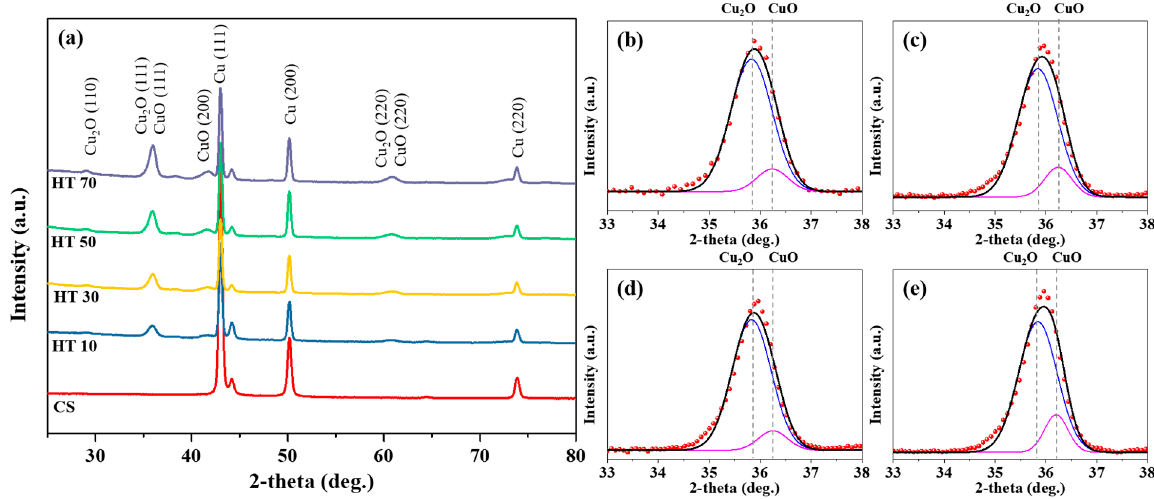
Figure 3. ( a ) X-ray diffraction of electrodeposited copper surface (CS) and electrodeposited copper surface with heat treatment for 10 min (HT10), 30 min (HT30), 50 min (HT50), and 70 min (HT70). Peak deconvolution (33°–38°) to CuO (36.24°) and Cu2O (35.82°) for ( b ) HT10, ( c ) HT30, ( d ) HT50, and ( e ) HT70. Dots and solid lines in ( b – e ) indicate measured and fitted data, respectively. Table 1. Calculated CuO/Cu 2 O ratios of electrodeposited copper surface with heat treatment for 10